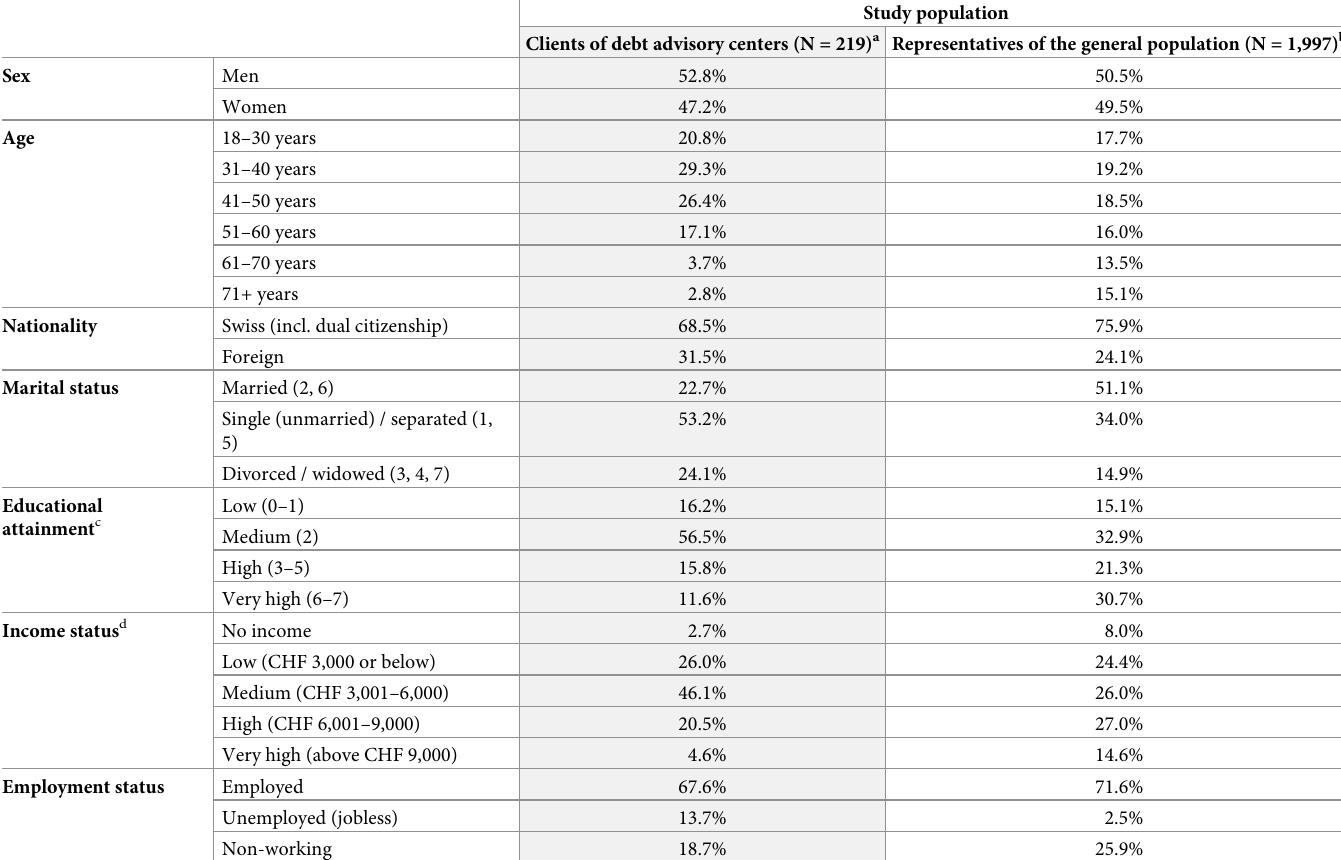
Table 1. Socio-demographic characteristics of the study population, stratified by subsamples (N = 2,216).